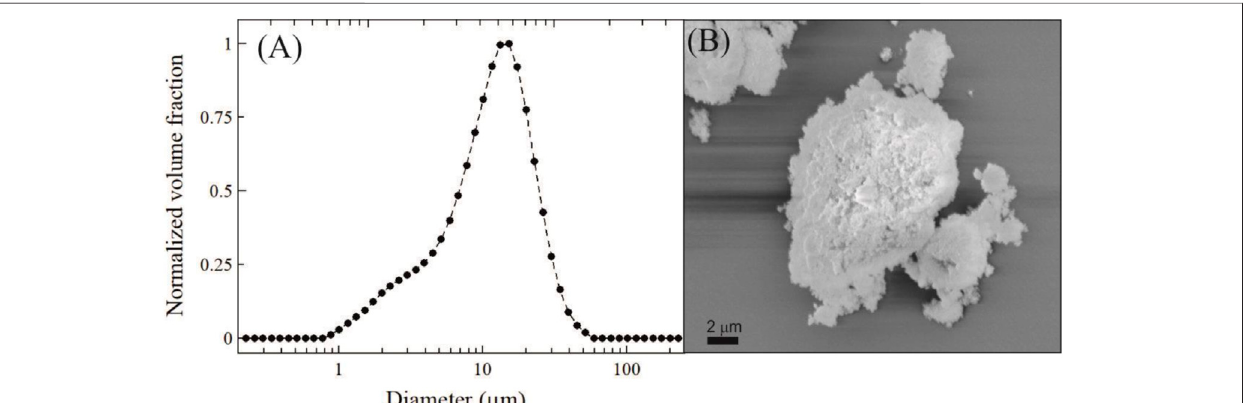
FIGURE 4 | (A) Particle size distribution of TCP by LD and (B) SEM micrograph of TCP particles.